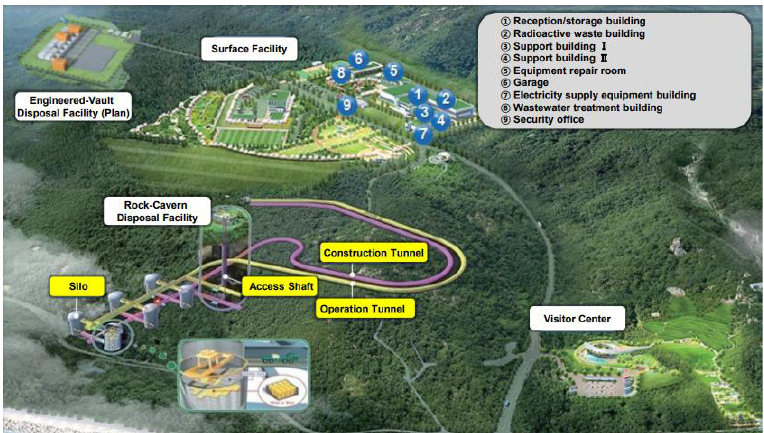
Figure 1. Location of the WLDC site in Korea.